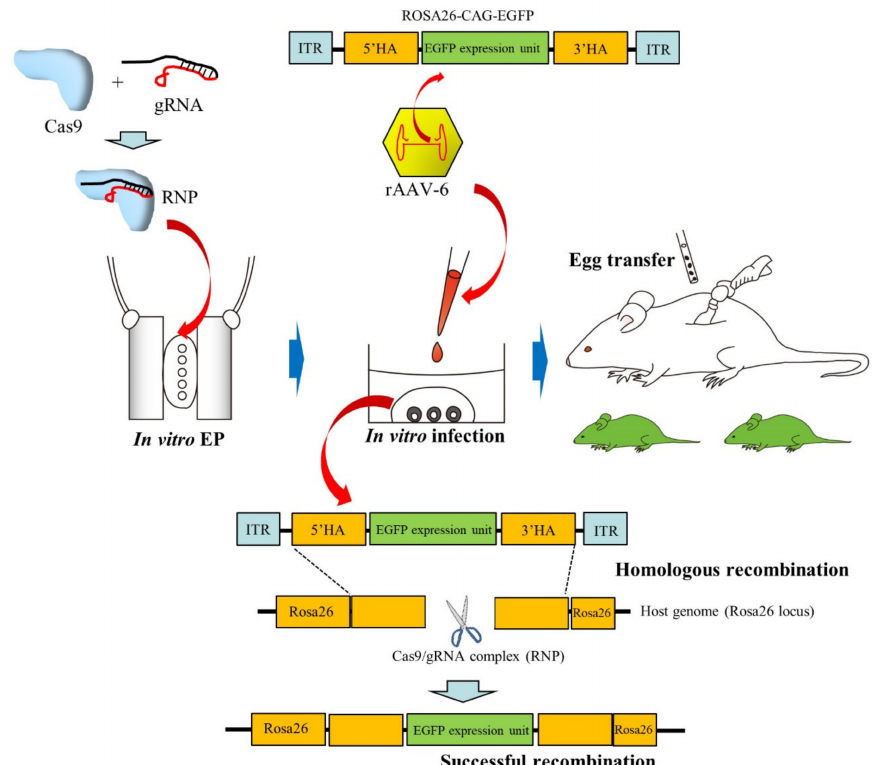
Figure 3. Schematic representation of recombinant adeno-associated virus-6 (rAAV-6)-based production of knock-in (KI) mice, according to the method of Mizuno et al. [9]: Zygotes are first subjected to in vitro electroporation (EP) in the presence of the Cas9 / gRNA complex (called ribonucleoprotein, RNP) and then subjected to infection with rAAV-6 carrying donor sequence (ROSA26-CAG-EGFP). After this, it is expected that CRISPR / Cas9-mediated KI of the donor sequence into the ROSA26 locus occurs in the infected zygotes. These treated zygotes are subsequently transferred to the oviducts of pseudopregnant females to generate KI